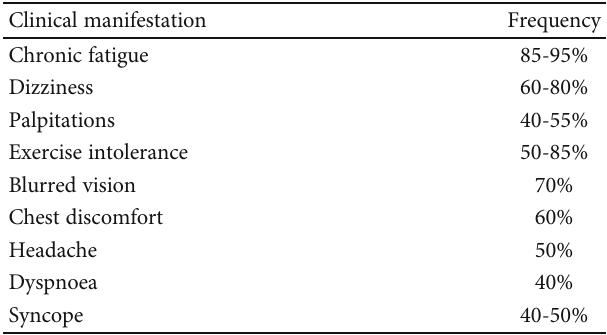
Figure 4: Hyperlaxity in the Table 1: Clinical manifestations and their relative frequencies in POTS.